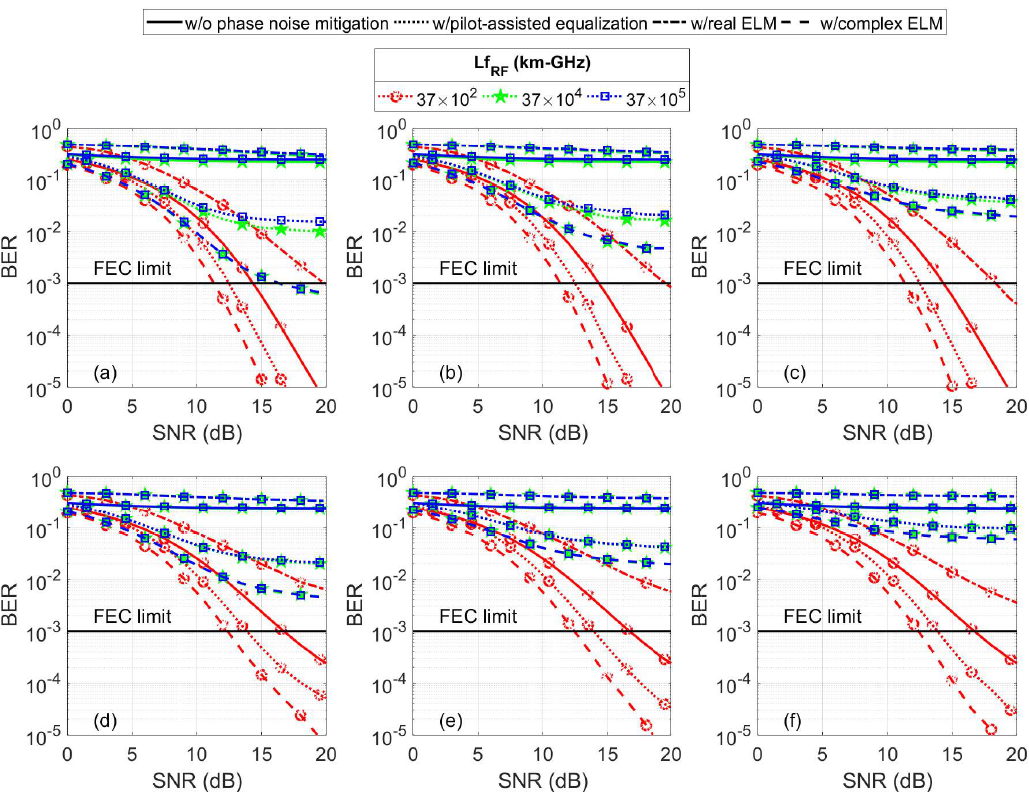
Figure 10. For the diverse phase error compensation methods, the BER vs. SNR with the relationship between the transmission distance and millimeter wave frequency as the parameter. The laser linewidth and OFDM symbol period equal to ( a ) 5 MHz and 3.2 ns, ( b ) 5 MHz and 6.4 ns, ( c ) 5 MHz and 12.8 ns,